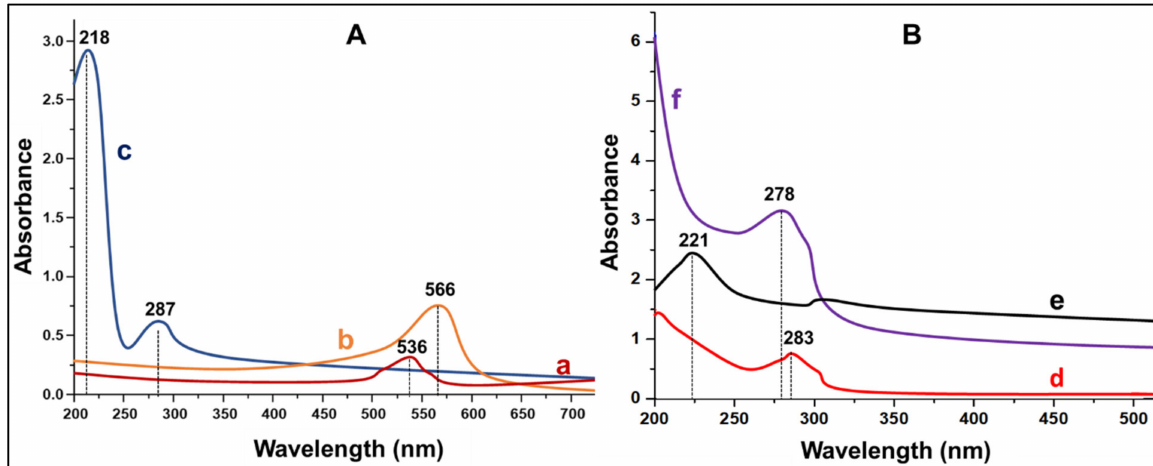
Figure 1. ( A ) UV spectra of ( a ) AuNPs, ( b ) Au:G5D NPs, ( c ) Au:G5D:FA NPs; and ( B ) UV-spectra of ( d ) G5D, ( e ) G5D:FA NPs, and ( f )